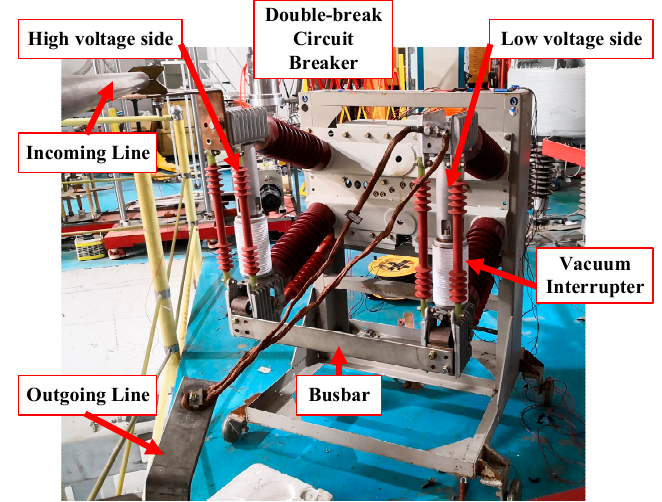
Figure 2. Picture of the experimental setup.